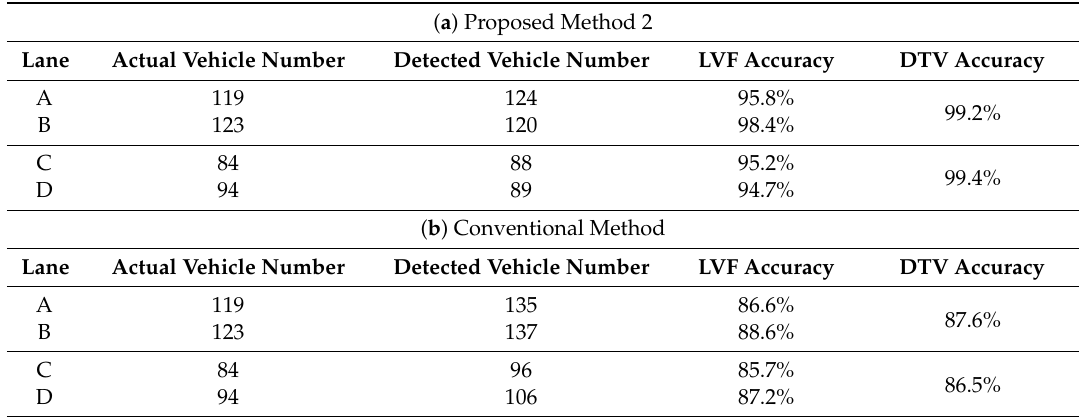
Table 10. Results of LVF and DTV detection during 7:30–7:40 PM (rush-hour traffic) using ( a ) proposed method 2 and ( b ) conventional method.